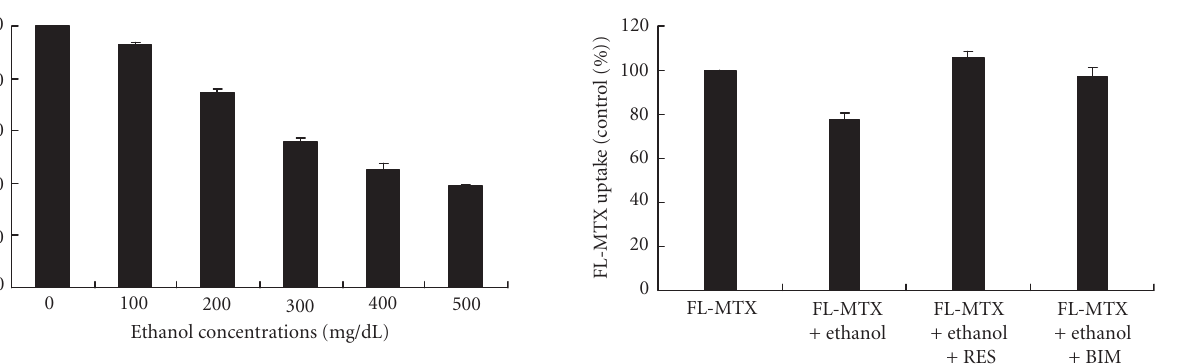
Figure 4: Fluoroskan studies of FL-MTX (10 μ M) uptake by HPT cells in 24 well plates treated with di ff erent concentrations (0, 100, 200, 300, 400, and 500 mg/dL) of ethanol. Ethanol concentration has an impact on FL-MTX uptake. Data are expressed as mean ± SEM ( n = 5).